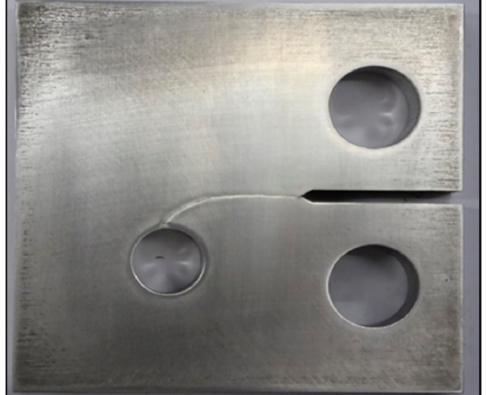
Figure 4. CT specimen modi fi ed with a hole, showing the crack path. FCG takes place under the predominant mode I situation, Ferreira et al.